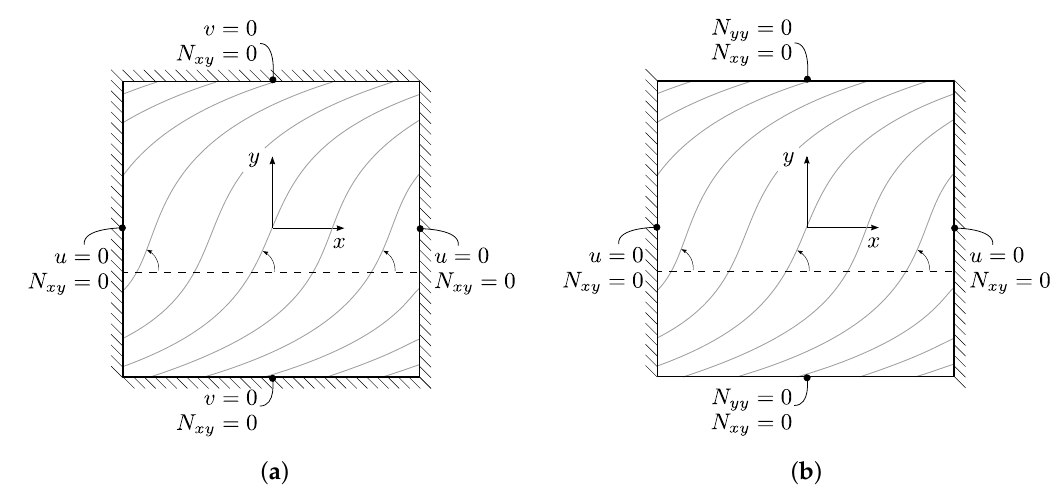
Figure 3. Pre-buckling boundary conditions for fiber variation along y : ( a ) Case-Ty1; ( b )